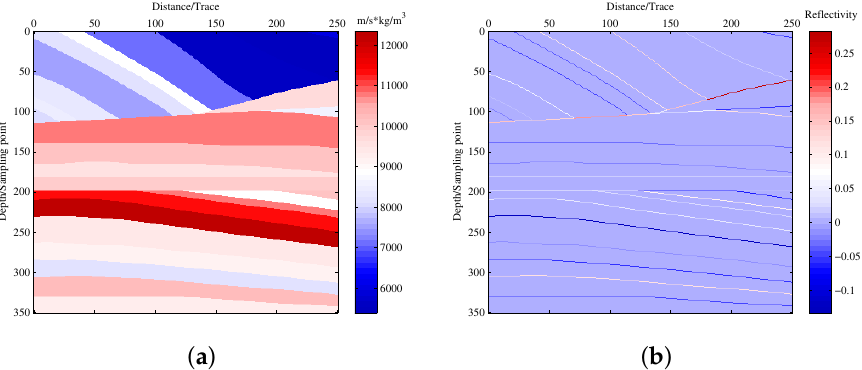
Figure 1. Acoustic impedance section and its reflection coefficient section for generating synthetic seismic data. ( a ) Acoustic impedance section; ( b ) reflection coefficient